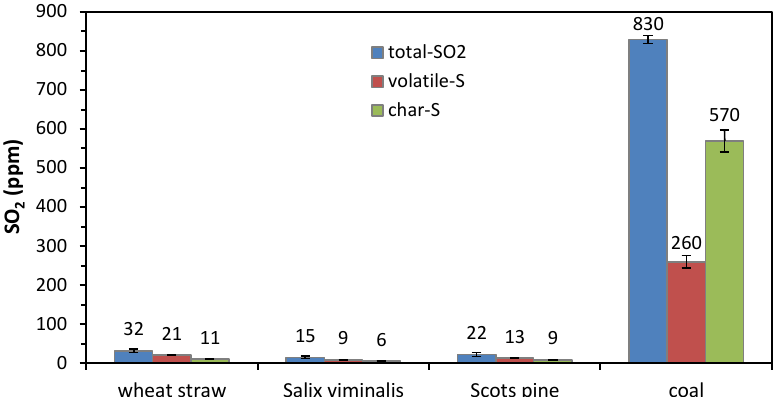
Figure 6. Effect of fuel type on the total SO 2 emissions during air combustion. Vertical bars represent standard deviation.